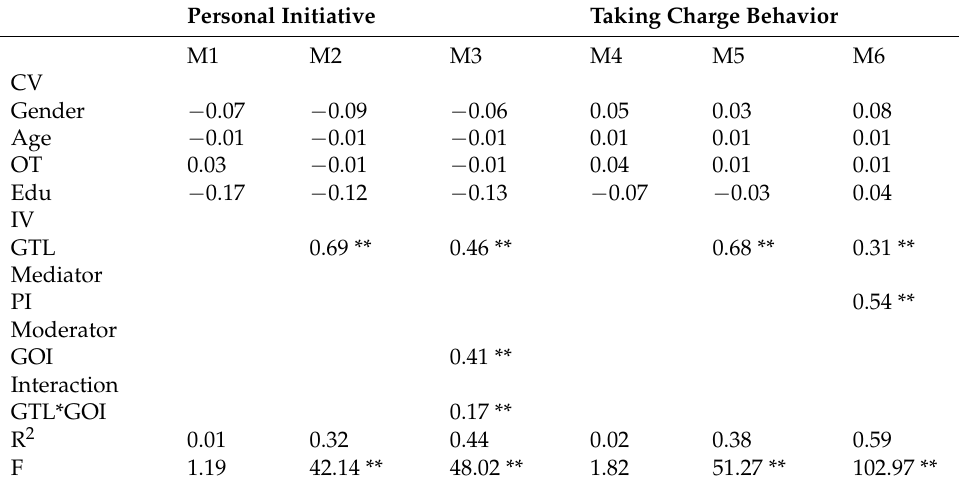
Table 3. Results of hierarchical multiple